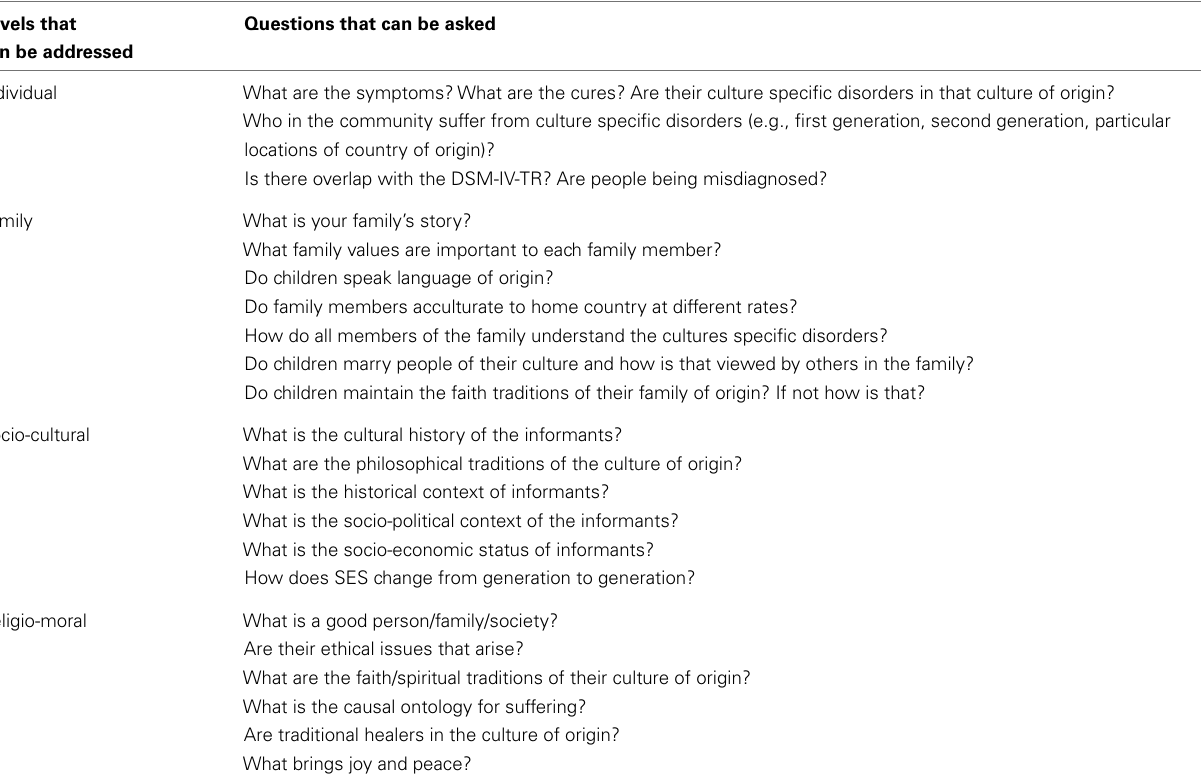
Table 2 |A model for doing therapy/research with people from other cultures. Levels that